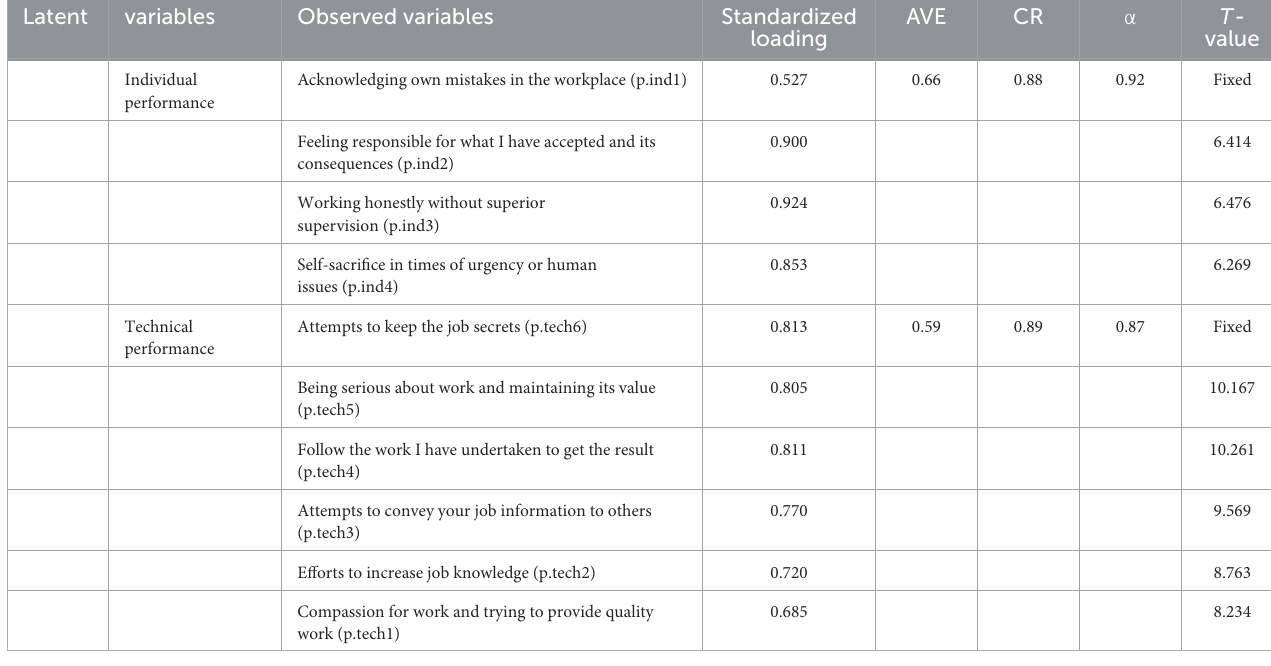
TABLE 2 The comparison of means of the research variables with mean